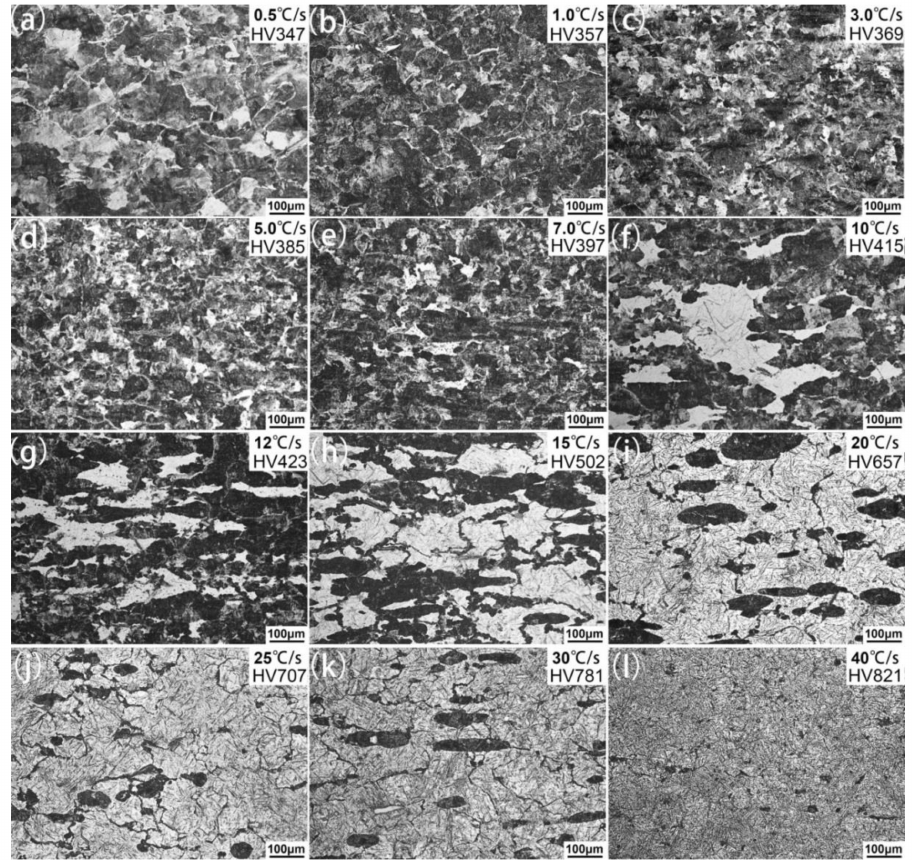
Figure 3. Microstructure and hardness of the specimens cooled at di ff erent rates: ( a ) 0.5 ◦ C / s, ( b ) 1 ◦ C / s, ( c ) 3 ◦ C / s, ( d ) 5 ◦ C / s, ( e ) 7 ◦ C / s, ( f ) 10 ◦ C / s, ( g ) 12 ◦ C / s, ( h ) 15 ◦ C / s, ( i ) 20 ◦ C / s, ( j ) 25 ◦ C / s, ( k ) 30 ◦ C / s, ( l ) 40 ◦ C /